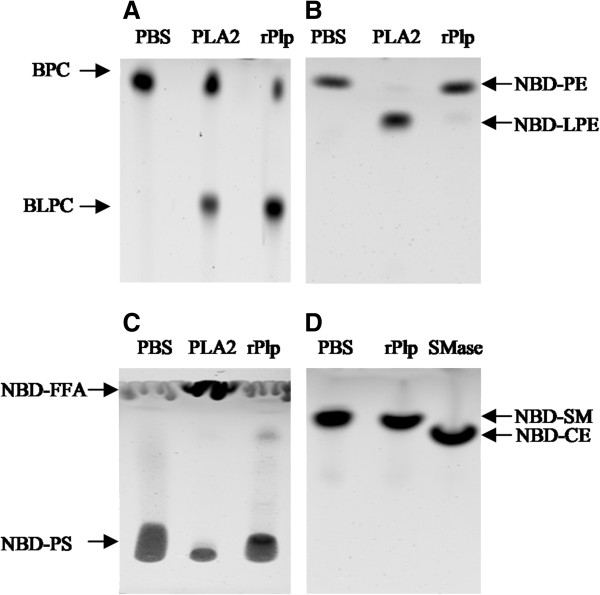
rPlp activity determined by TLC analysis. BPC (A), NBD-PE (B), NBD-PS (C), and NBD-Sm (D) were used as phospholipid substrates to examine the specificity of rPlp. Phosphate-buffered saline (PBS) was used as a negative control, and PLA2 enzyme from porcine pancreas as a positive control. BPC: BODIPY-labeled phosphatidylcholine; BLPC: BODIPY-labeled lysophosphatidylcholine; NBD-PE: NBD-labeled phosphatidylethanolamine; NBD-LPE: NBD-labeled lysophosphatidylethanolamine; NBD-PS: NBD-labeled phosphatidylserine; NBD-FFA: NBD-labeled free fatty acid; NBD-SM: NBD-labeled sphingomyelin; NBD-CE: NBD-labeled ceramide.